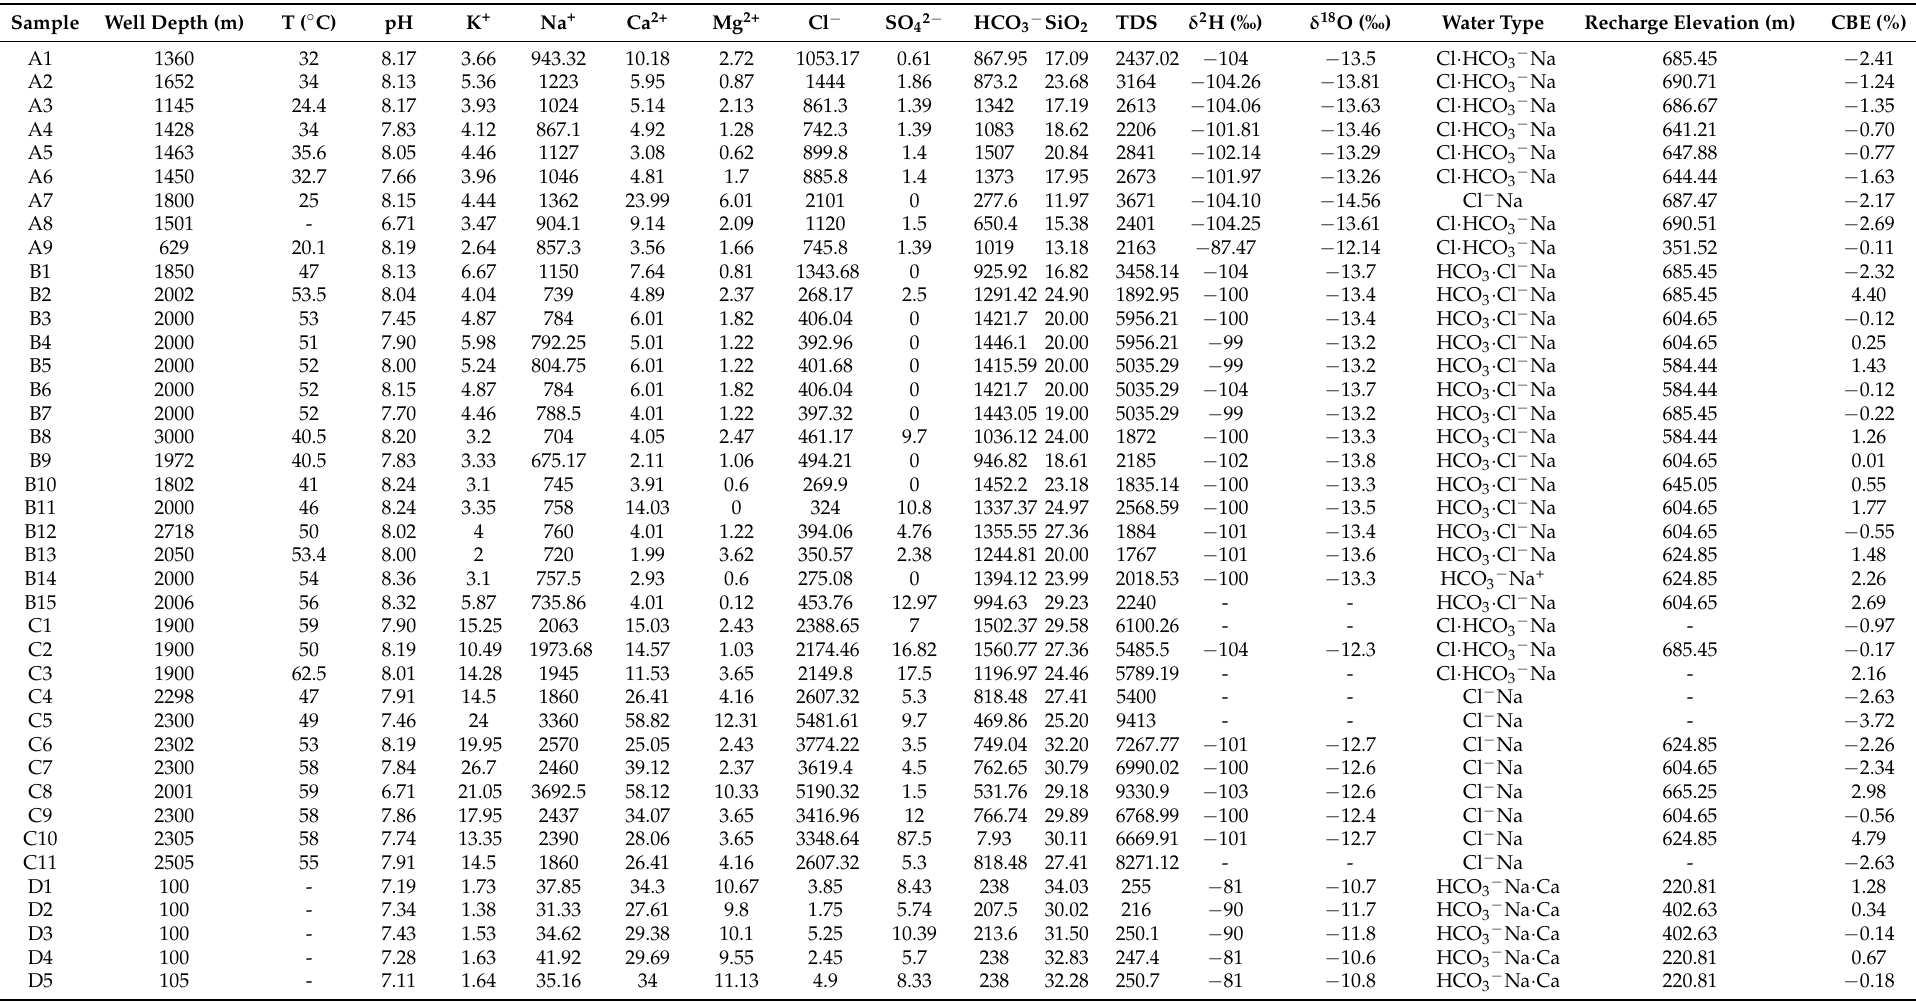
Table 1. Hydrochemical and isotopic characteristics of the sampled waters from west Songnen Plain, China (unit: